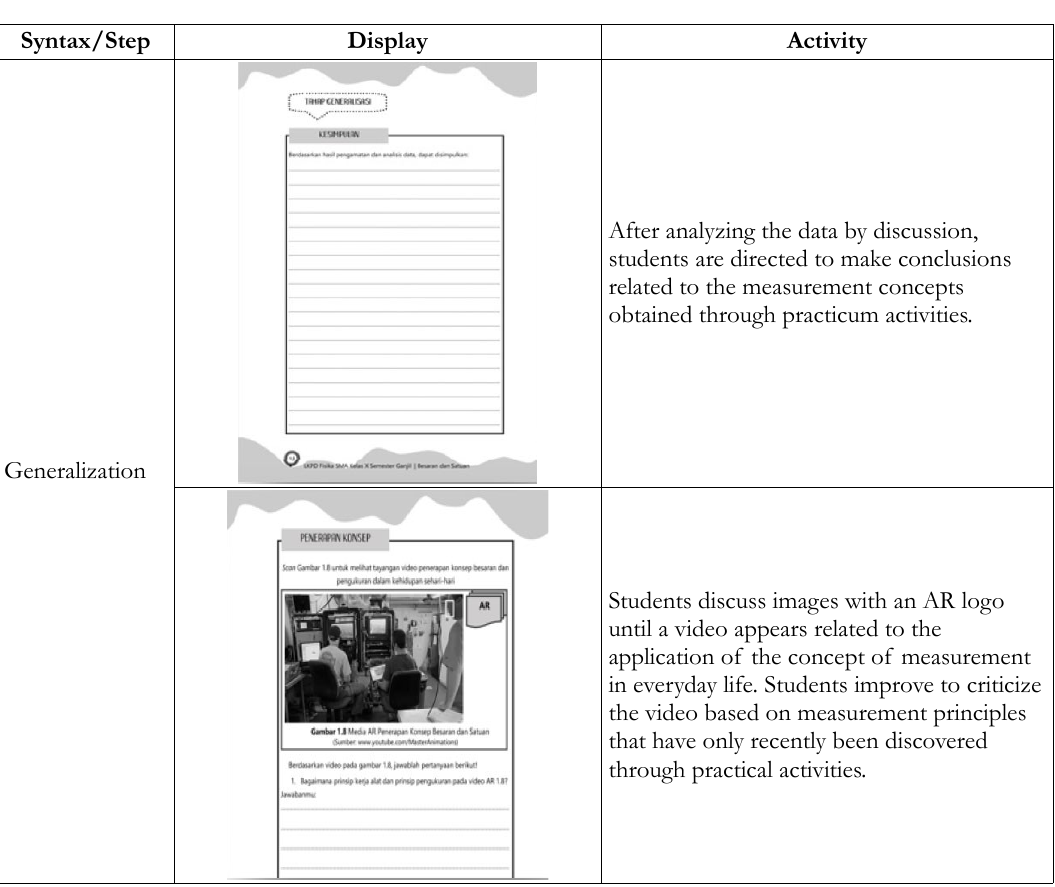
Table 1. The steps of discovery learning in the student worksheet